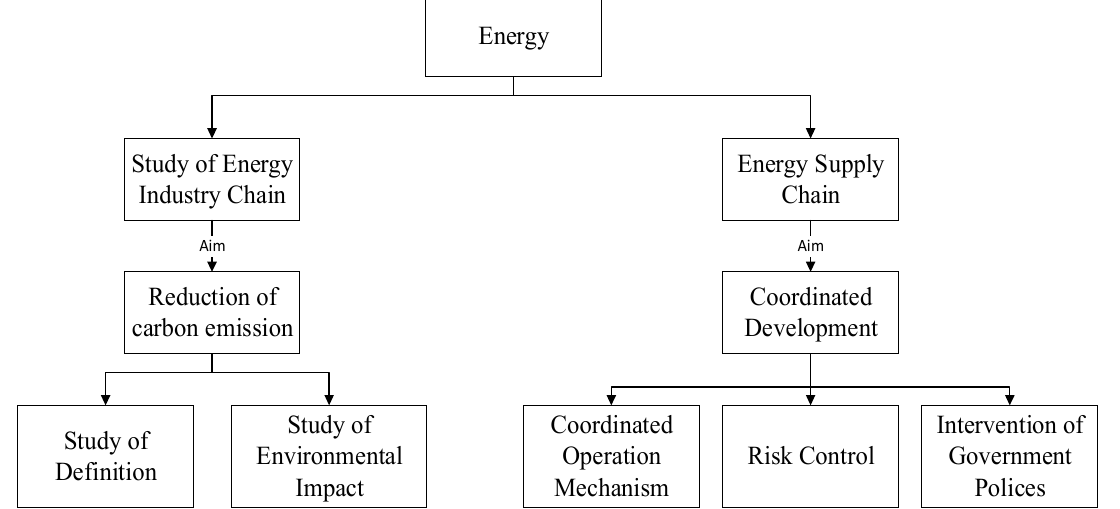
Figure 1. Structure of the Literature Review.